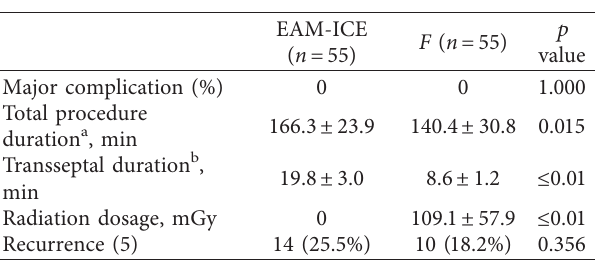
Figure 5: Radiofrequency catheter ablation of paroxysmal atrial fibrillation accomplished via zero-fluoroscopy transseptal puncture guided by EAM-ICE. Table 1: Baseline patient characteristics. Table 2: